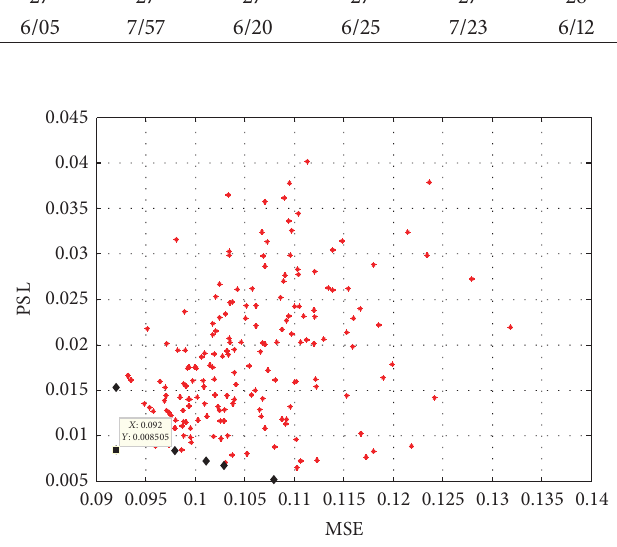
Figure 9: Pareto fronts produced by MODE.